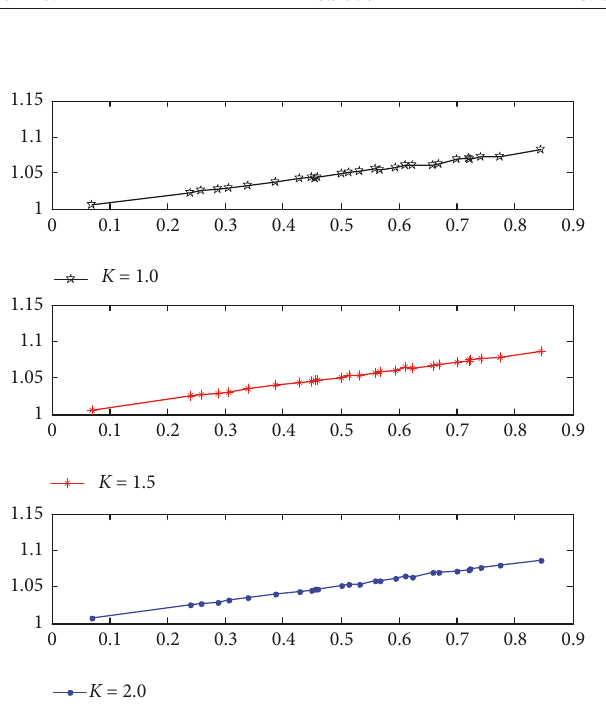
Figure 6: The inversion result of the thermal conductivity.